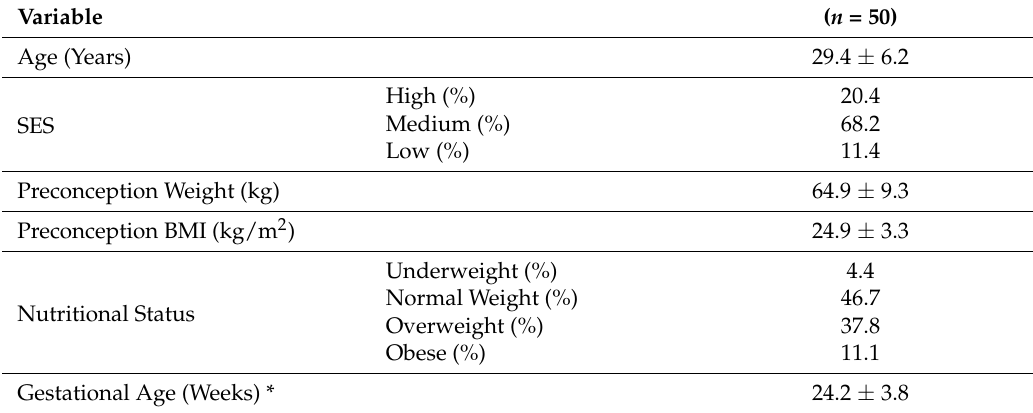
Table 1. Background characteristics of the women at the study enrollment.